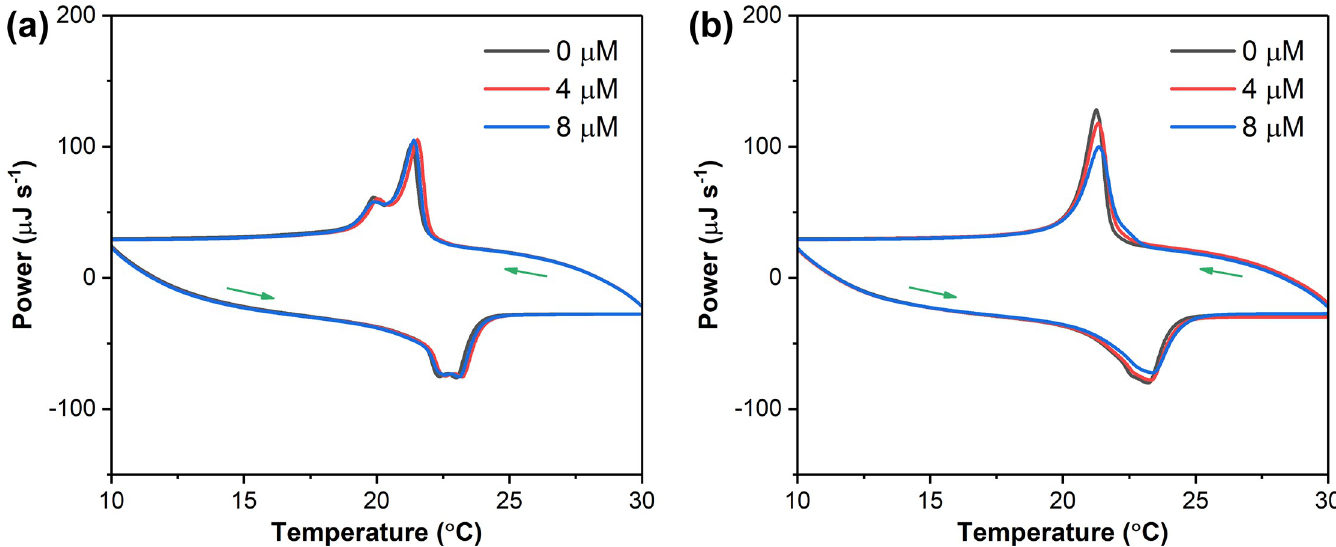
Fig 5. DSC curves at heating and cooling rates of 1˚C min − 1 of 1 mg mL − 1 (a) neat POPE:POPG SUVs and (b) 8 μ M COE-S6 -treated SUVs after treatment with different concentrations COE-D8 .